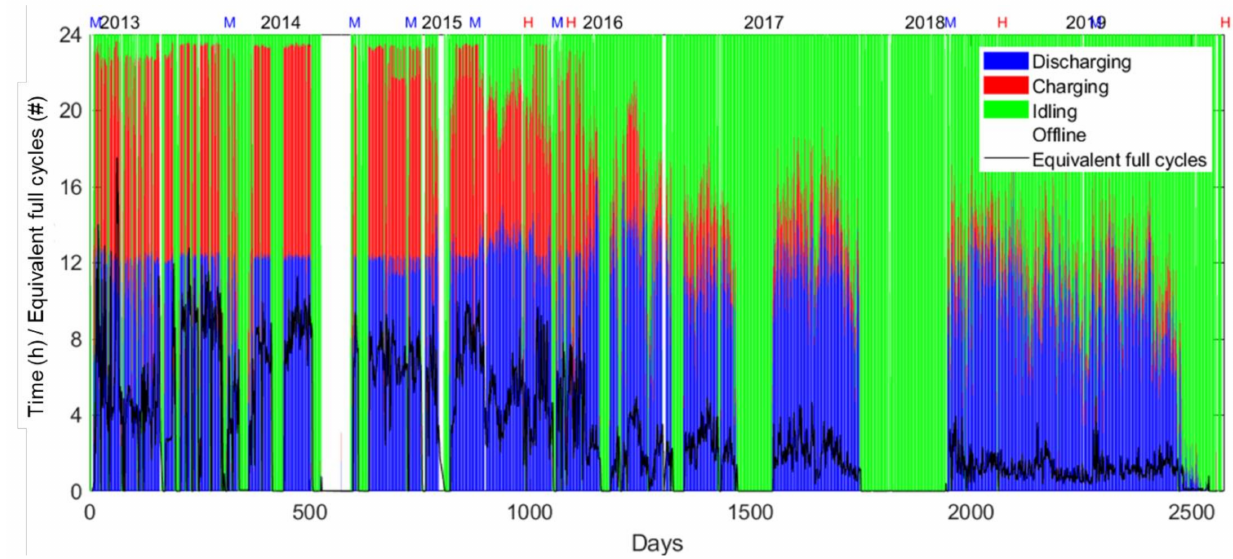
Figure 2. 2013–2019 Battery Energy Storage System activity showcasing discharging time (blue), charging time (red), idling time (green) and offline time (white). The M and H letters highlight the running of reference testing following the manufacturer and HNEI’s protocols, respectively. The black curve represents the daily equivalent full cycle